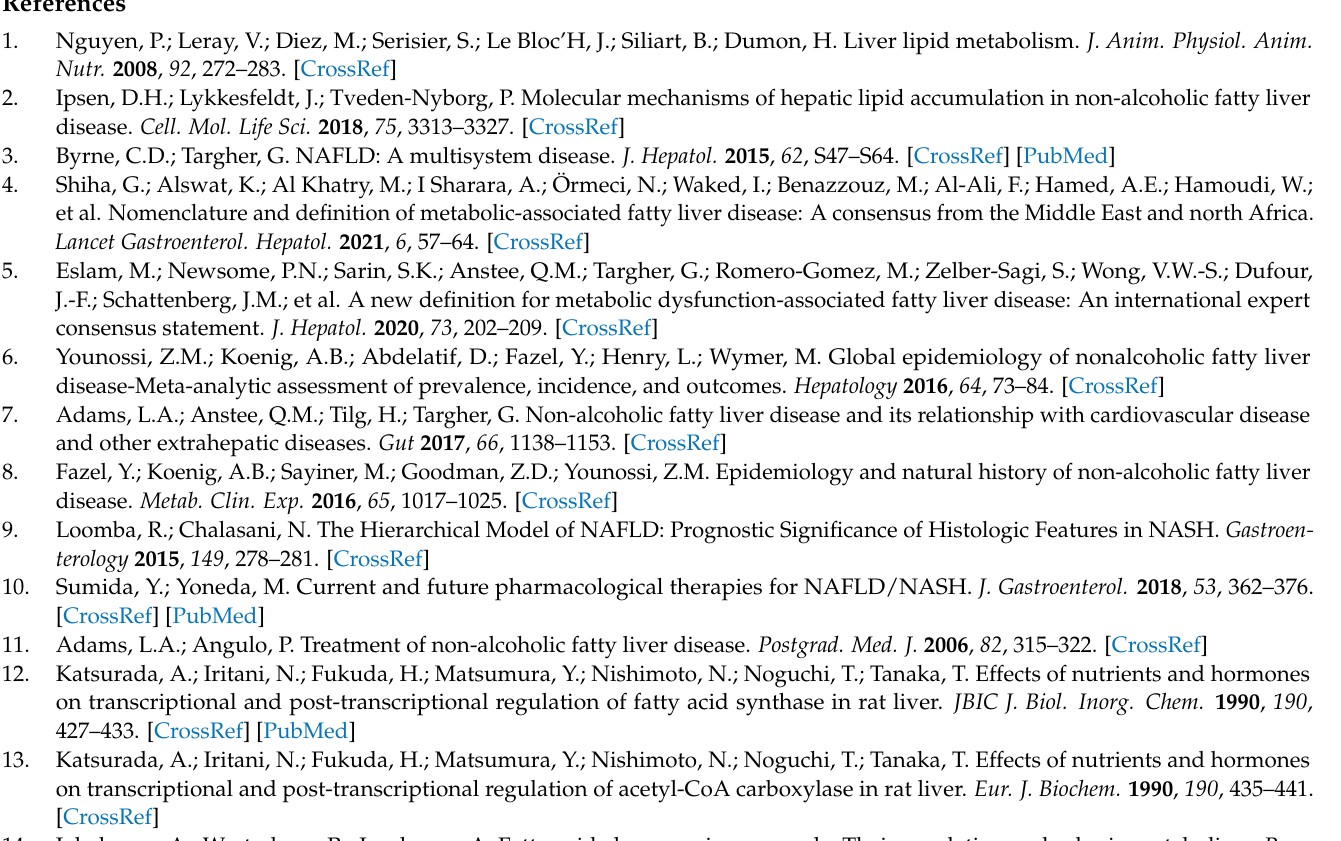
Figure S4: Effects of tanshinone IIA on LXR α -mediated transcriptional activity in HepG2